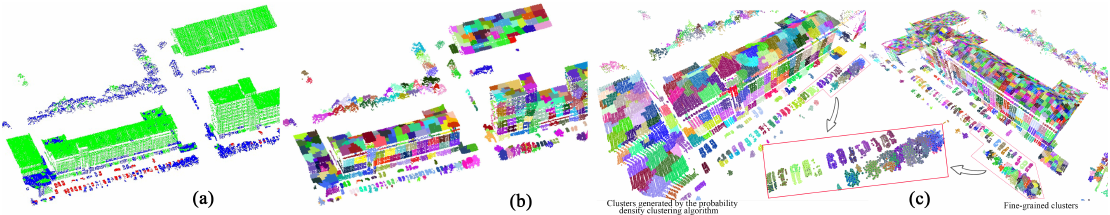
Figure 5. Neighborhood topology maintenance between the fine-grained clusters. ( a ) The initial coarse labels. ( b ) The results of the proposed probability density clustering. ( c ) The inclusive relationship between the clusters generated by the proposed probability density clustering and the fine-grained clusters. The inclusive relationships are clearly shown in the enlarged view in subfigure ( c ) by the overlap of the two kinds of